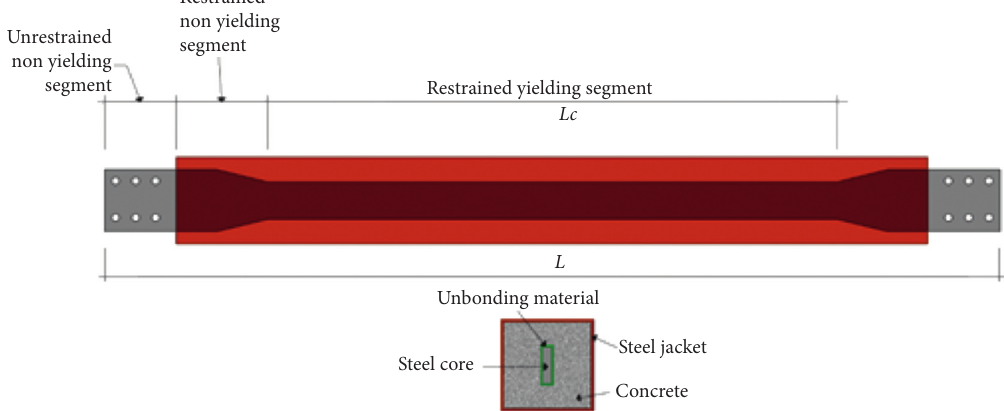
Figure 1: Buckling restrained brace parts and cross section